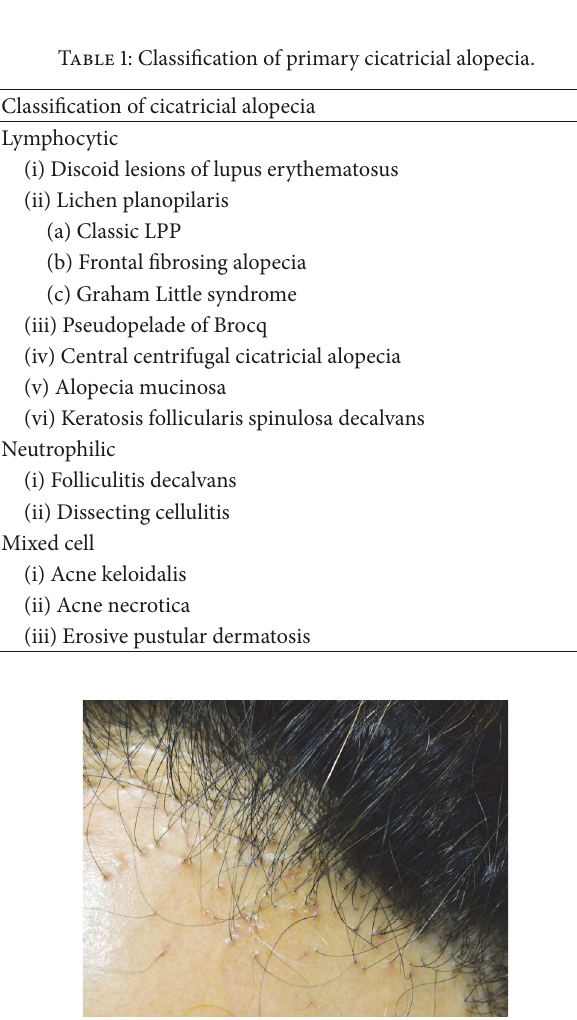
Figure 1: Clinical signs of cicatricial alopecia. The scalp shows a loss of follicular ostia, and the residual hairs show perifollicular erythema and